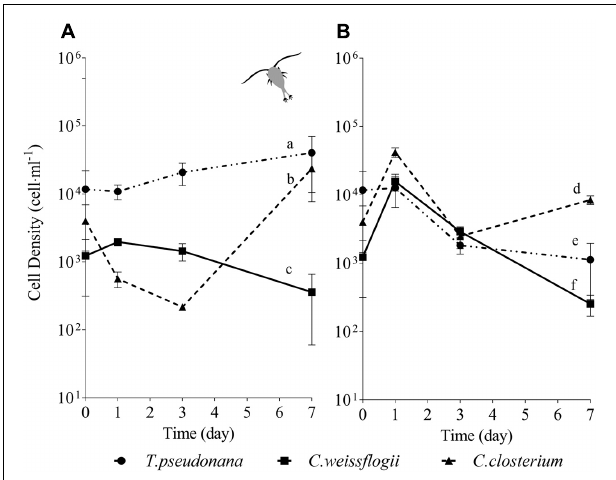
FIGURE 5 | Comparison between growth curves of the diatom mix without P. tricornutum exposed (A) or not (B) to copepods. The data are means of 3 biological replicas. Error bars show SD while letters indicate significant differences according to two-way ANOVA followed by Tukey’s post-hoc test, p < 0.05 ( Supplementary Table 11